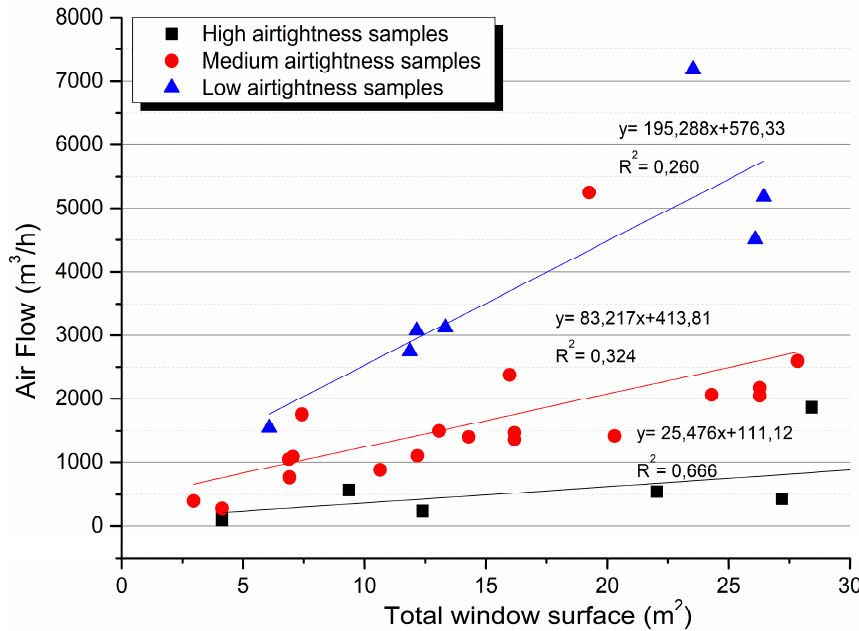
Figure 10. Correlation between airflow and window surface of the tested enclosures, according to the identified airtightness levels.